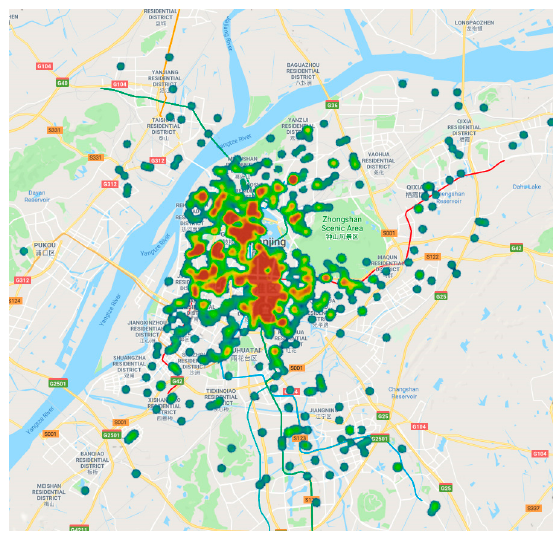
Figure 9. Spatial distribution of FFBS at the weekends.